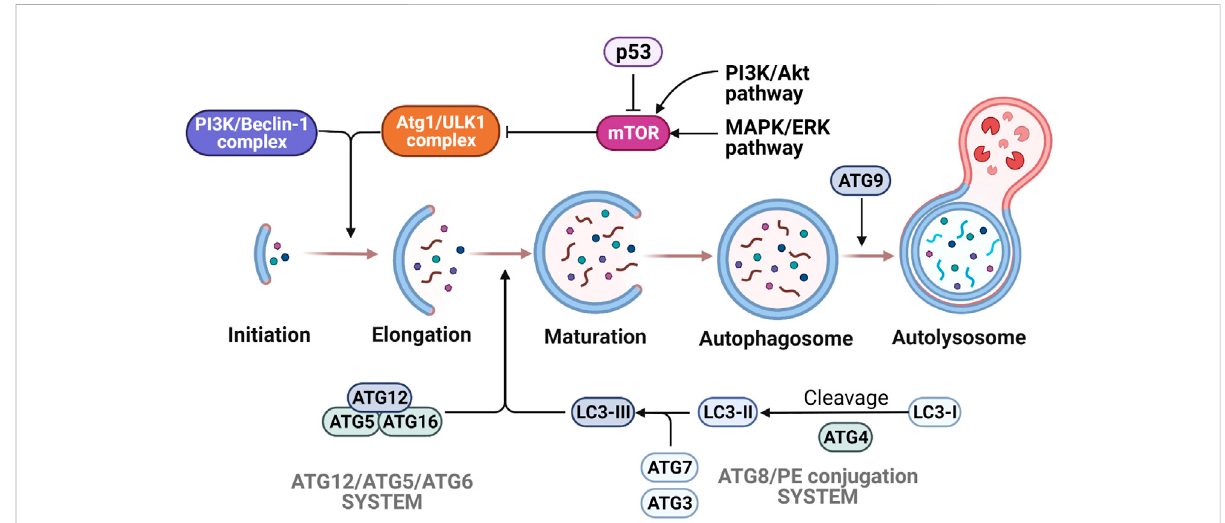
FIGURE 5 Molecular mechanisms of autophagy. The various steps of autophagy process are depicted following mTORC1 regulation by p53, AMPK and MAPK/ERK signaling. Autophagy is activated by the initiation complex ULK1/Atg1 and PIK3/Beclin-1 complex, which enables the autophagosome formation. The elongation and maturation depend on two ubiquitin-like conjugation systems (Atg12/Atg5/Atg6 system and Atg8/PE system). Many signalingpathwaysareinvolvedintheregulationofautophagy.Duetotheactivation ofp53signalingorAMPK,activityofthemTORC1complex is decreased and triggers autophagy activation. On the other hand, the activation of PI3K/Akt and MAPK/Erk pathways induce the increase of mTORC1 activity that results in the inhibition of